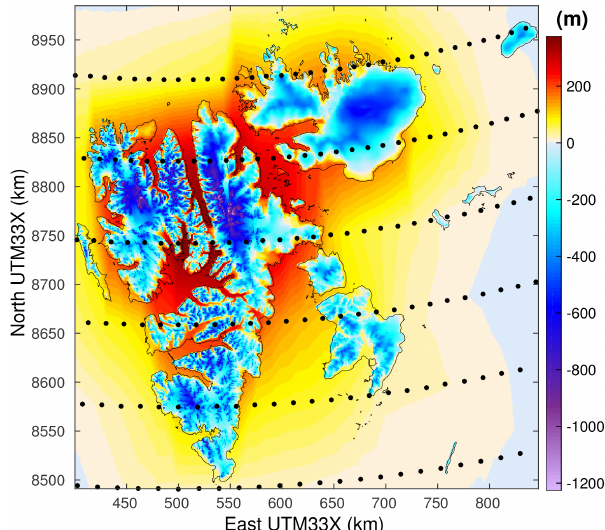
Figure 3. Elevation difference (m) between the ERA topography and the 1km DEM; negative values mean that ERA elevations are lower. Black dots show the 0 . 75 ◦ × 0 . 75 ◦ ERA